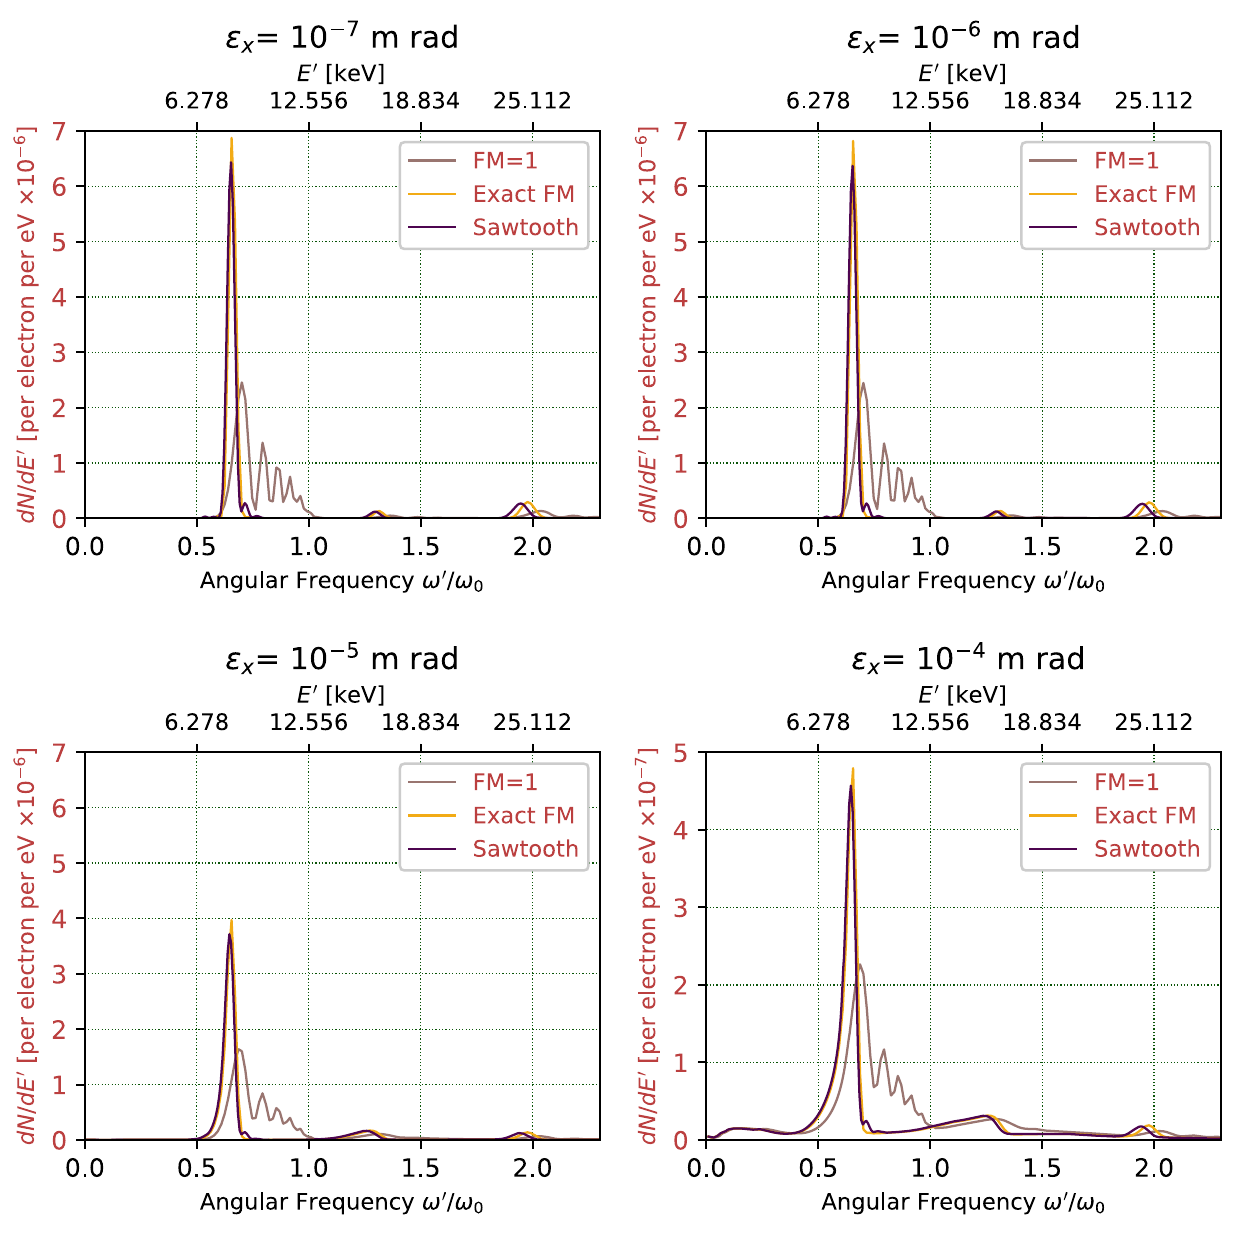
FIG. 6. Comparison of simulated spectra with three different FM functions: uncorrected simulation (FM ¼ 1 ), the optimal chirping solution [11], and a sawtooth chirping function. The simulations were conducted for a range of normalized horizontal emittance ϵ x values. In the case of the most extreme emittance (bottom right panel), the spectra have been rescaled by an order of magnitude on the right vertical axis. The following parameters were used in the simulations: E e ¼ 23 MeV; Δ E e =E e ¼ 0 . 175% ; σ x ¼ 41 μ m; σ ¼ 81 μ m; a ¼ 1 . 5 ; λ ¼ 800 nm; σ ¼ σ ¼ 13 . 59 μ m; σ ¼ 5 . 57 . Note that the scale of the y-axis is fixed for the top two y 0 x;l y;l plots and the lower left plot, but the scaling on the bottom right plot has been adjusted since the peaks are a full order of magnitude smaller than the other